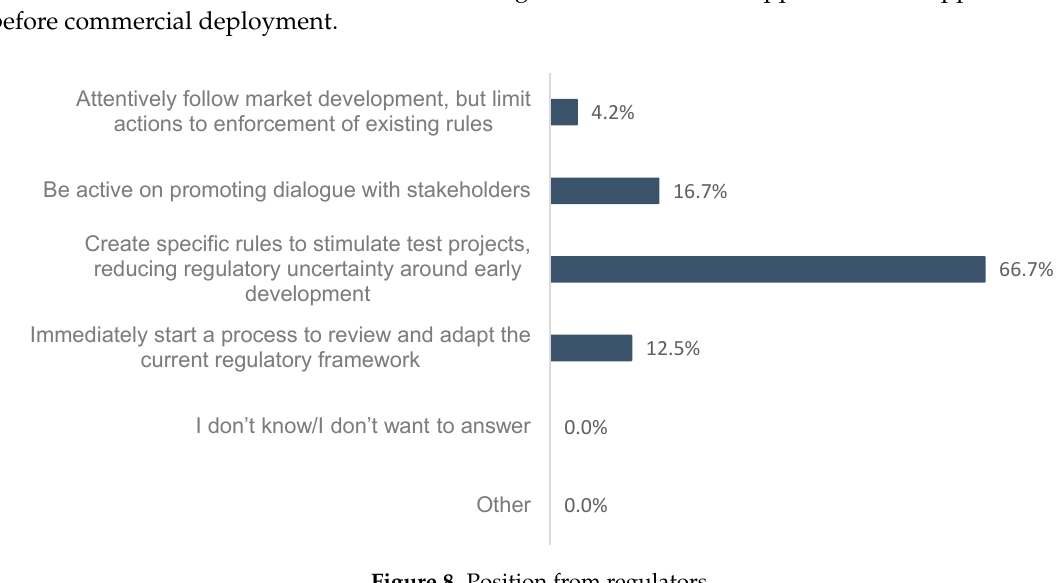
Figure 8. Position from Figure 8. P osition from regulators.